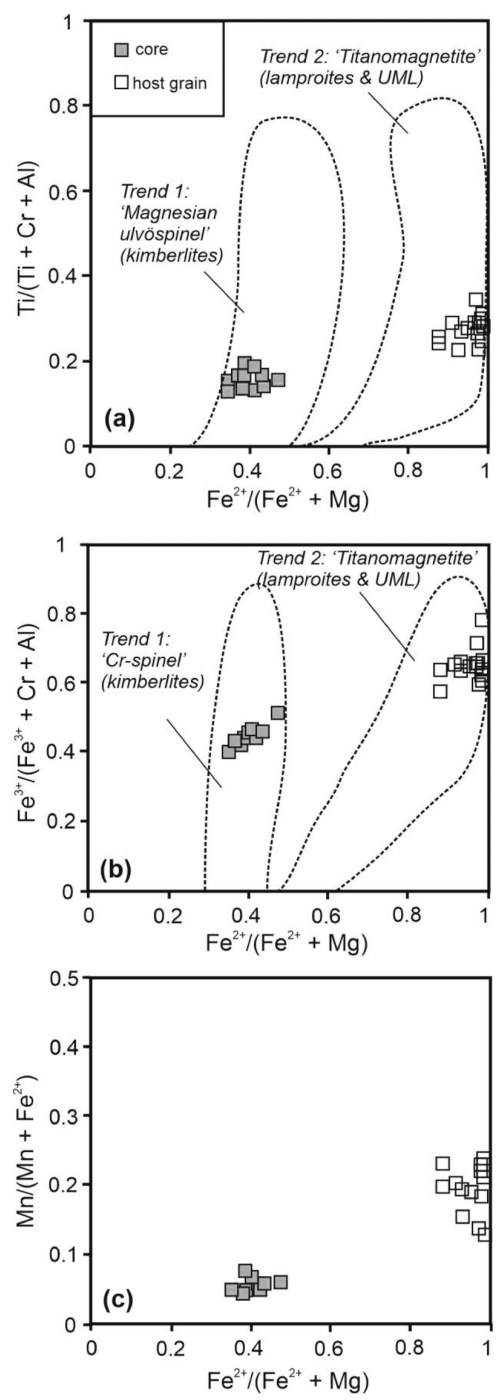
Figure 12. Variations in ( a ) Ti / (Ti + Cr + Al), ( b ) Fe 3 + / (Fe 3 + + Cr + Al) and ( c ) Mn / (Mn + Fe 2 + ) vs. Fe 2 + / (Fe 2 + + Mg) of spinel from the studied rock. The compositional fields for magnesian ulvöspinel / Cr-spinel from kimberlites (trend 1) and titanomagnetite from lamproites and UML (trend 2) are from